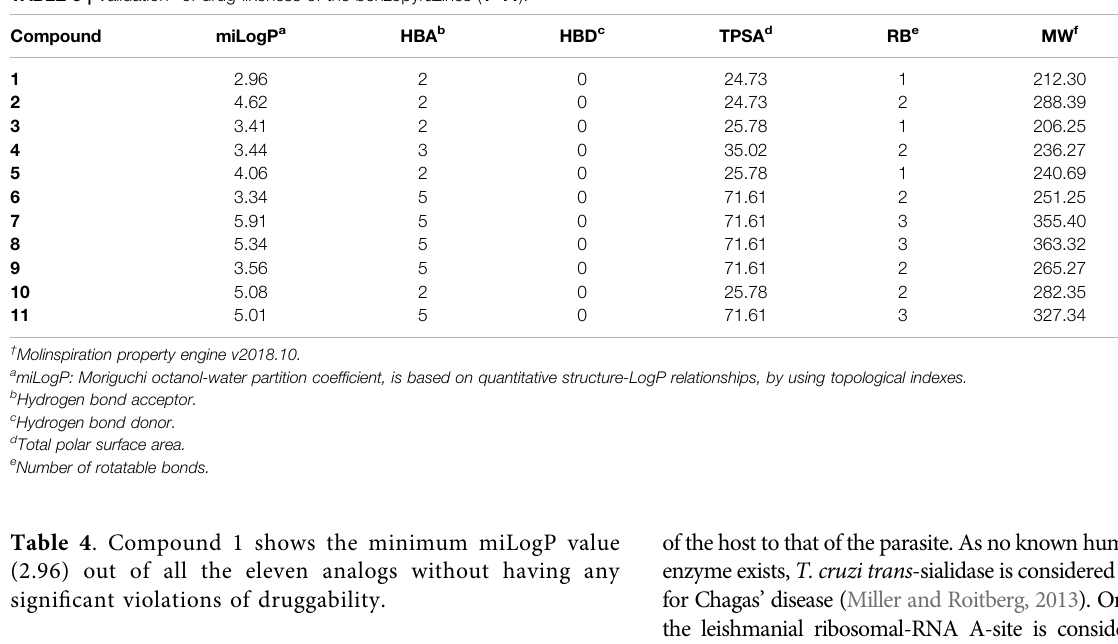
Table 4 . Compound 1 shows the minimum miLogP value (2.96) out of all the eleven analogs without having any signi fi cant violations of druggability.